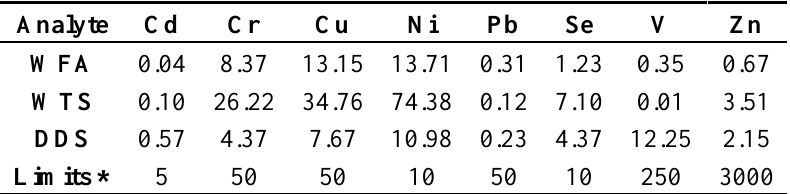
Table 4. Metals release of samples: Weathered Fly Ash (WFA), Wastewater